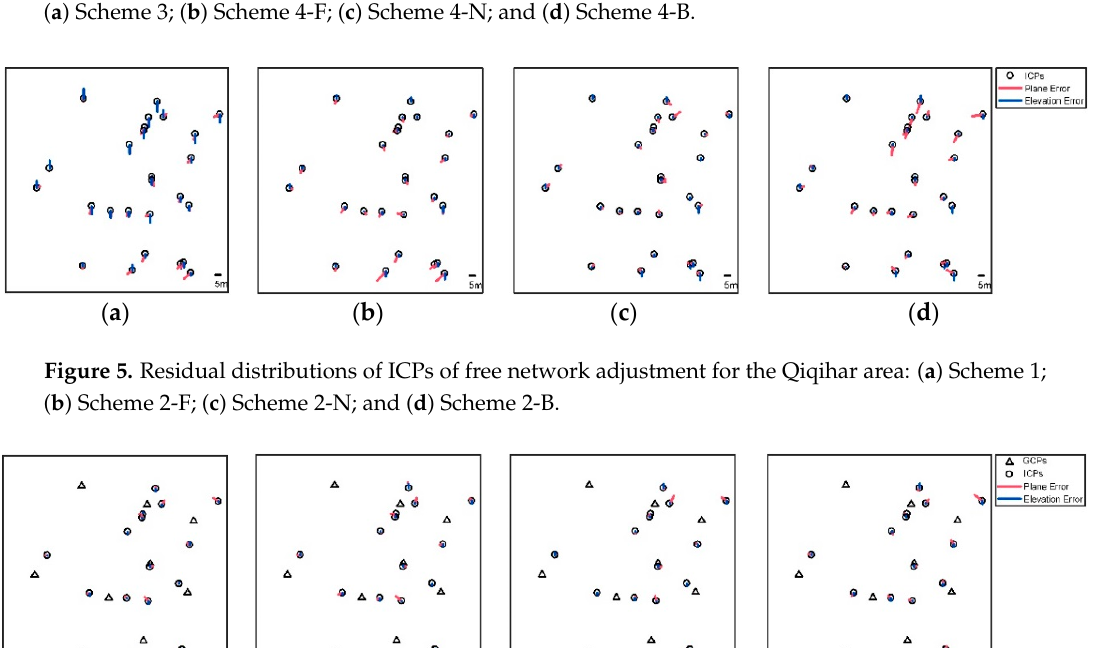
Figure 6. Residual distributions of ICPs of controlled network adjustment for the Qiqihar area: ( a ) Scheme 3; ( b ) Scheme 4-F; ( c ) Scheme 4-N; and ( d ) Scheme 4-B.